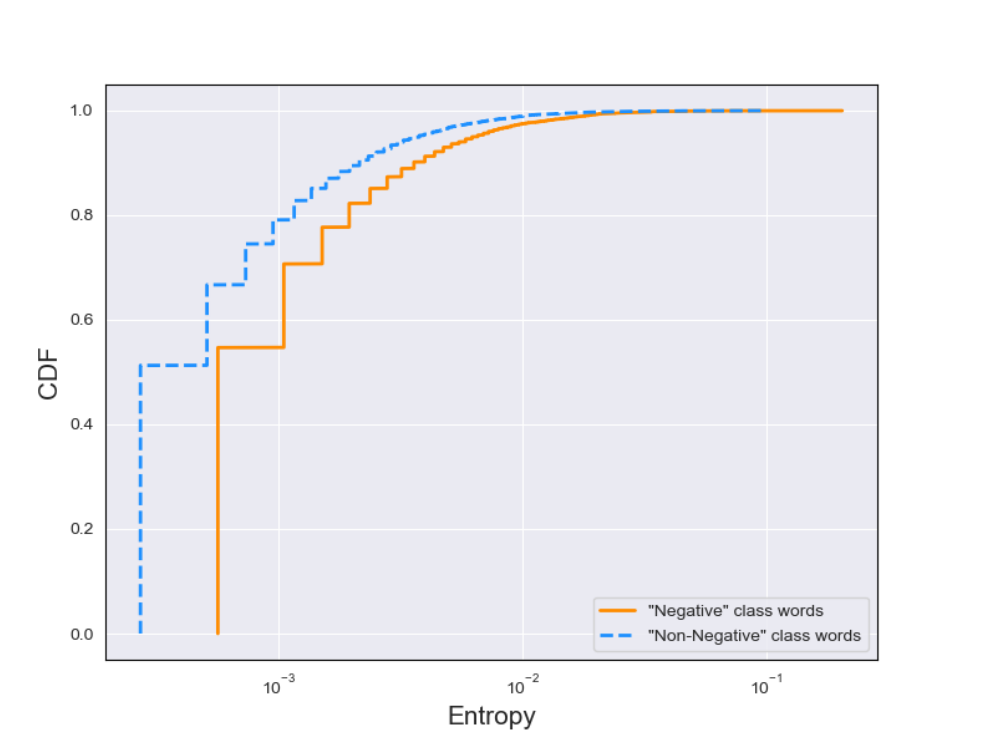
Figure 6. Cumulative Distribution Function representing text entropy for both